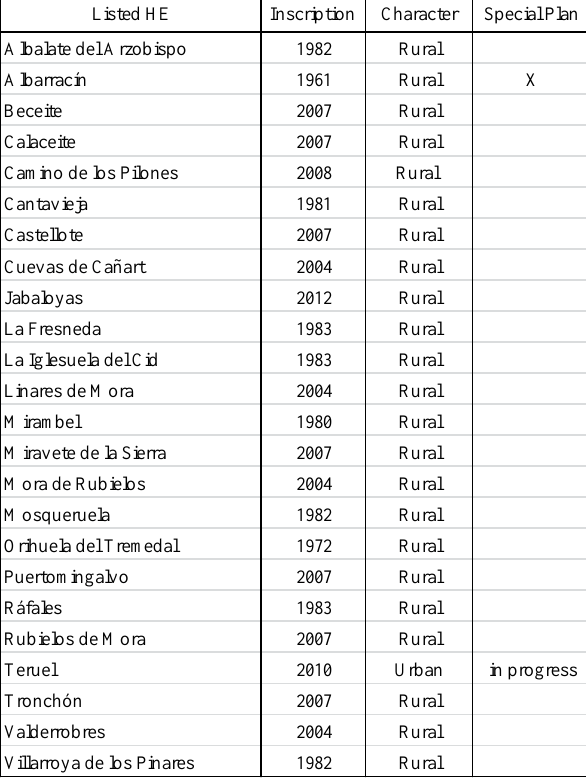
Table 1. Listed Historic Ensembles in